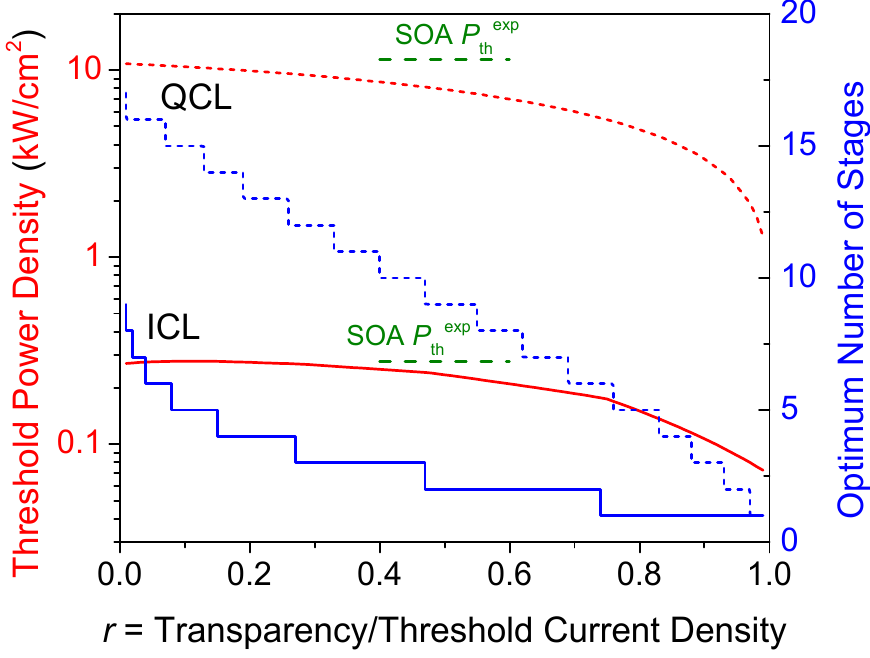
Figure 27. Minimum pulsed room-temperature threshold power densities and the corresponding optimum number of stages for ICLs (solid) and QCLs (dashed) emitting at λ = 4.0 µ m, plotted vs. the ratio of the transparency to threshold current densities. Experimental threshold power densities for state-of-the-art ICLs and QCLs, extrapolated to the 4.0- µ m wavelength, are indicated. Reproduced from Ref. [73], with the permission of IEEE.